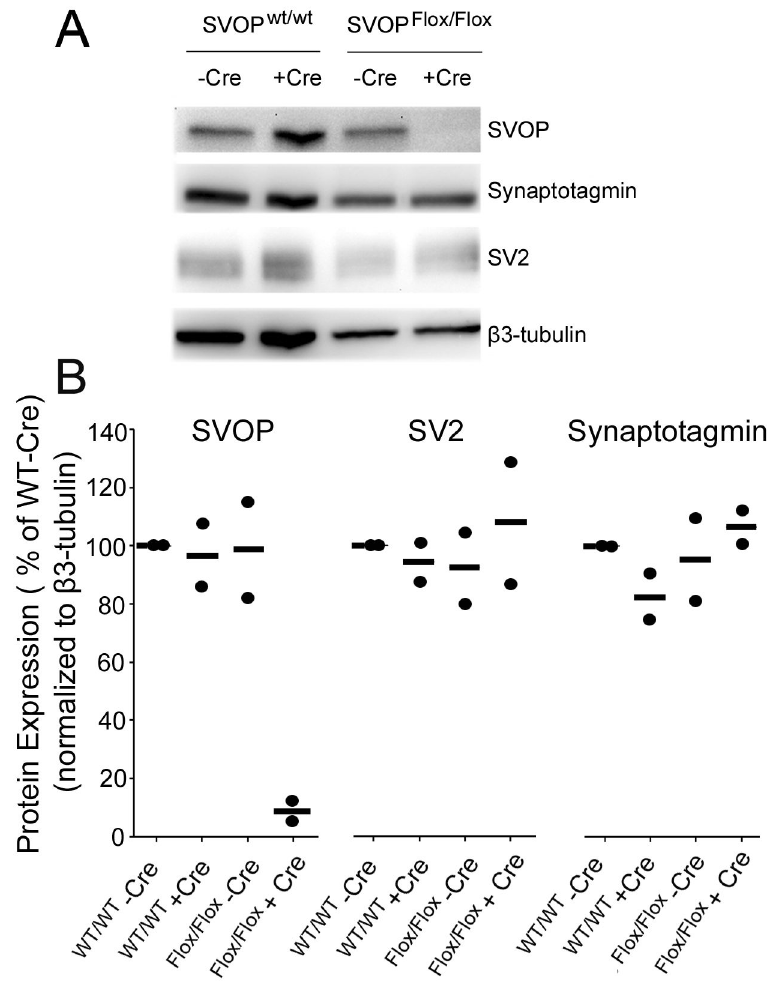
Figure 2. Cre recombinase disrupts SVOP expression in neurons from mice homozygous for the floxed SVOP gene. A ) Shown are representative Western blots of protein expression in primary hippocampal neurons cultured from newborn pups homozygous for the targeted SVOP gene, or from wild type pups. Neurons were infected with lenti virions encoding Cre-eGFP or eGFP. The expression level of SVOP and the indicated proteins were detected by Western blot analysis. β3-tubulin, a neuron- specific isoform of tubulin, was probed for as a loading control. B ) Plots of Western blot results from two independent experiments. Each dot represents one datum, and a horizontal line indicates the mean. The signals for SVOP, SV2 and synaptotagmin were normalized to β3-tubulin in the same lane and expressed as a percentage of the wild type - Cre lane in the same blot. SVOP was dramatically decreased in SVOP Flox/Flox neurons expressing Cre. Expression of the synaptic vesicle proteins synaptotagmin and SV2 was similar across